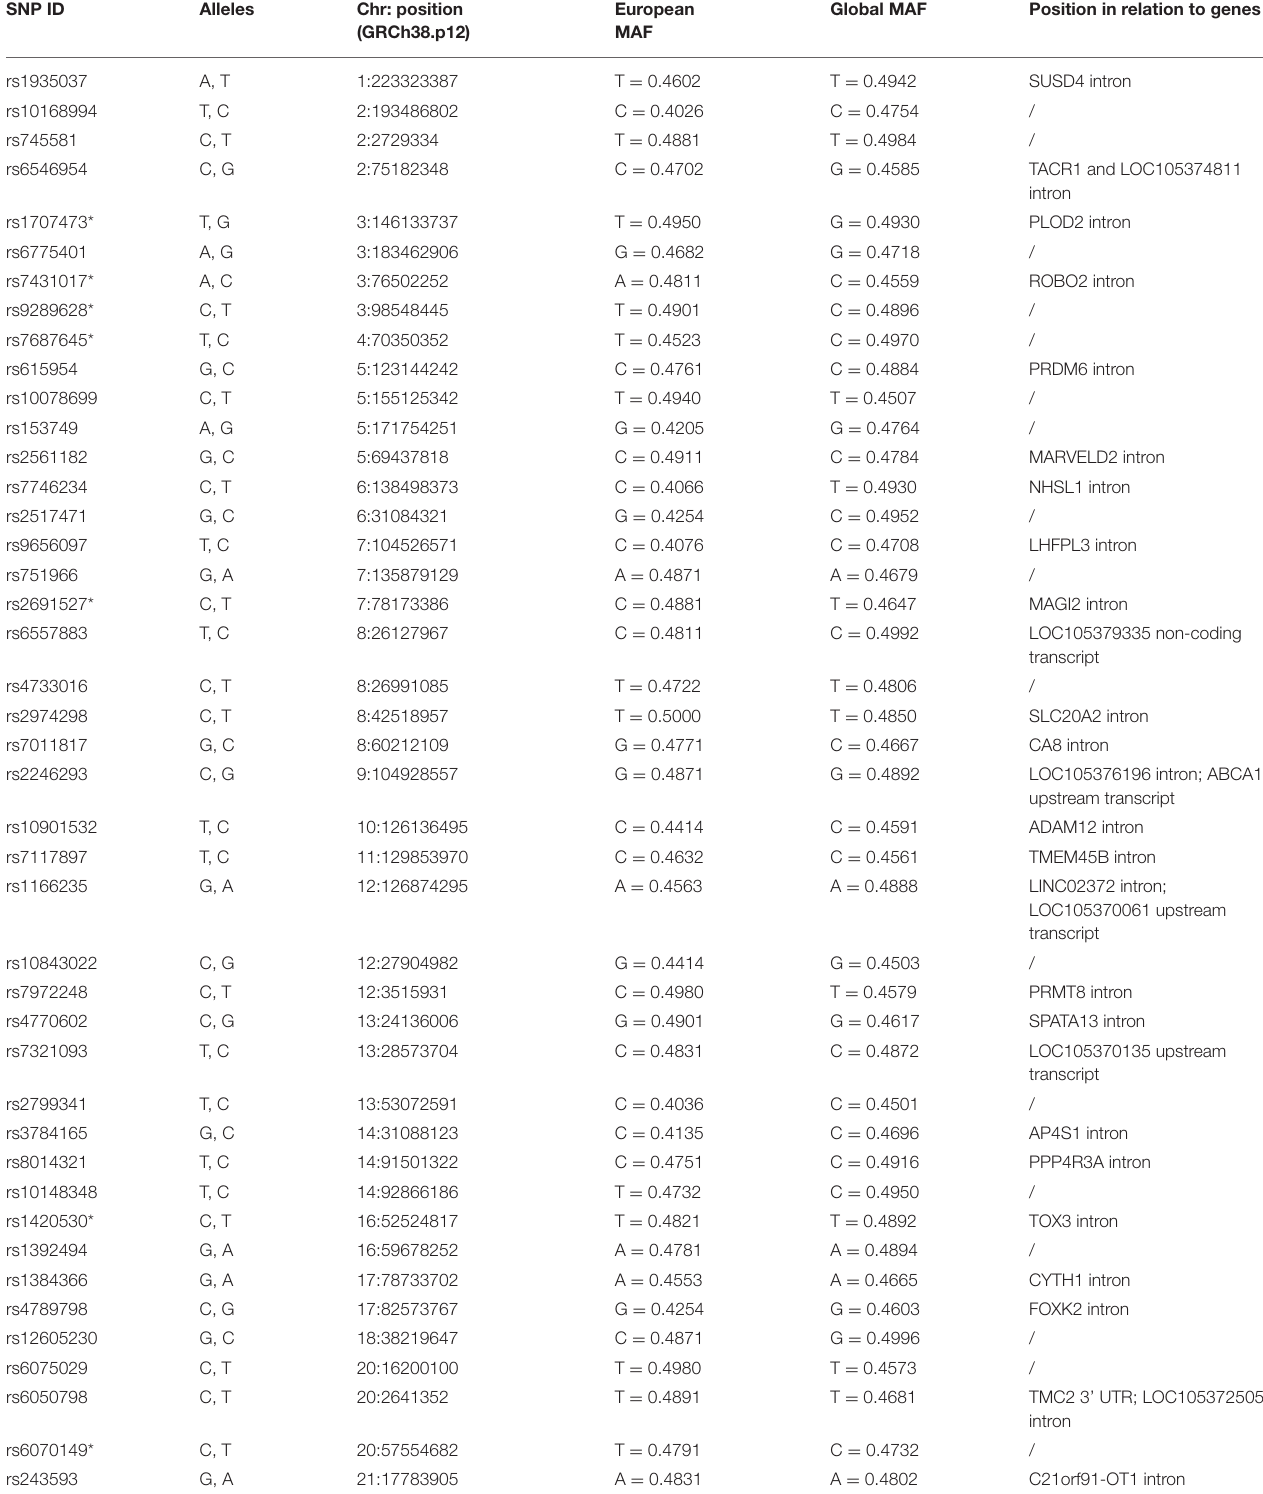
TABLE 1 | Proposed biallelic SNPs for distinguishing the cfDNA of two individuals. SNP ID Alleles Chr: position